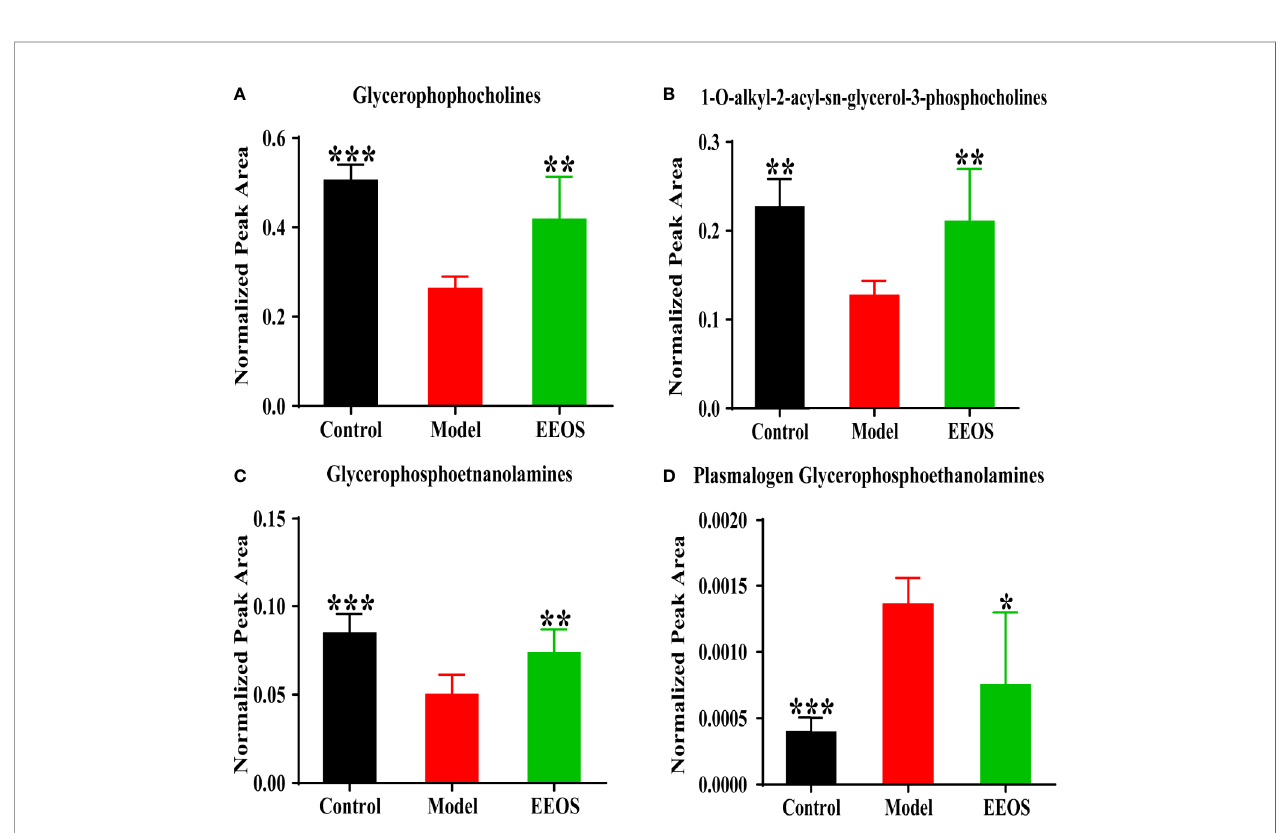
FIGURE 6 | Analysis of glycerophosphocholines and glycerophosphoethanolamines in three groups. (A) The content of glycerophosphocholines in each group. The model group was signi fi cantly decreased compared with the control group and EtOAc extract of OS (EEOS) group; (B) analysis of 1-O-alkyl-2-acyl-sn-glycero-3- phosphocholines in three group. The model group was also signi fi cantly reduced compared with the control group and EEOS group; (C) The content of glycerophosphoethanolamines in each group. The model group was signi fi cantly decreased compared with the control group and EEOS group; (D) analysis of plasmalogen glycerophosphoethanolamines in three group. The model group was signi fi cantly increased compared with the control group and EEOS group. Data are expressed as mean ± SD. * P < 0.05, ** P < 0.01, *** P < 0.001 vs. the model